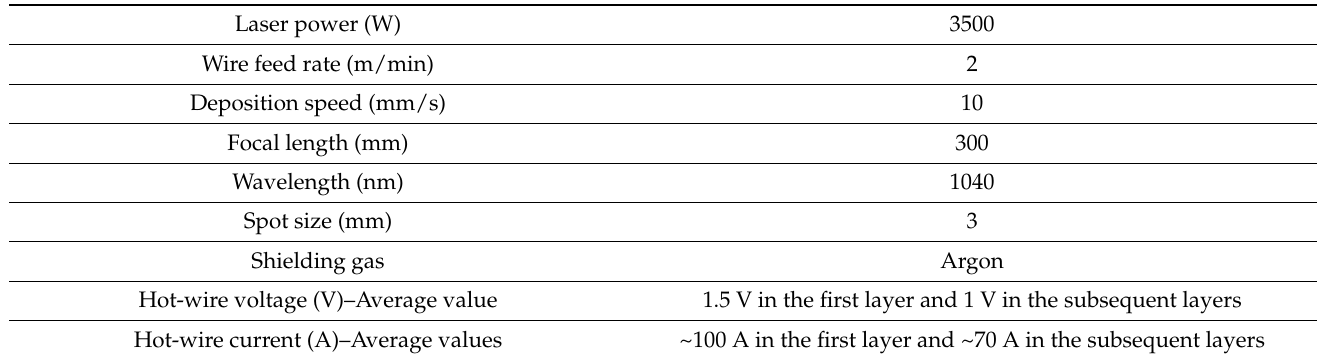
Table 3. LMDw process